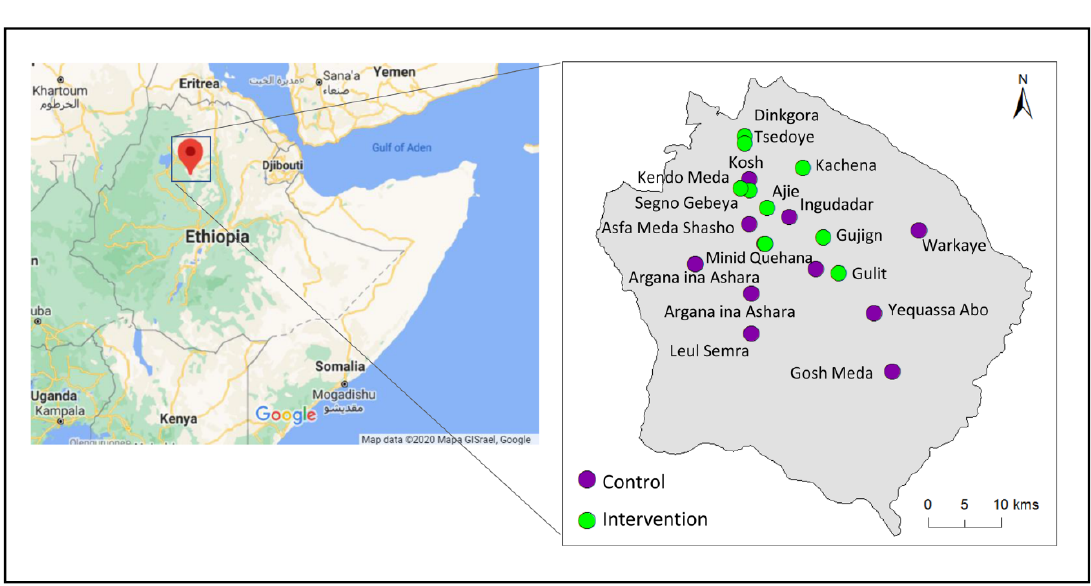
Figure 1. Map of all included HP in Simada District by allocation group.